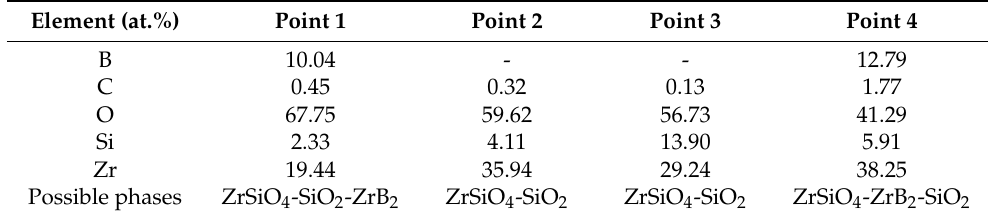
Table 6. EDS results of the center of the coating after ablation. Element